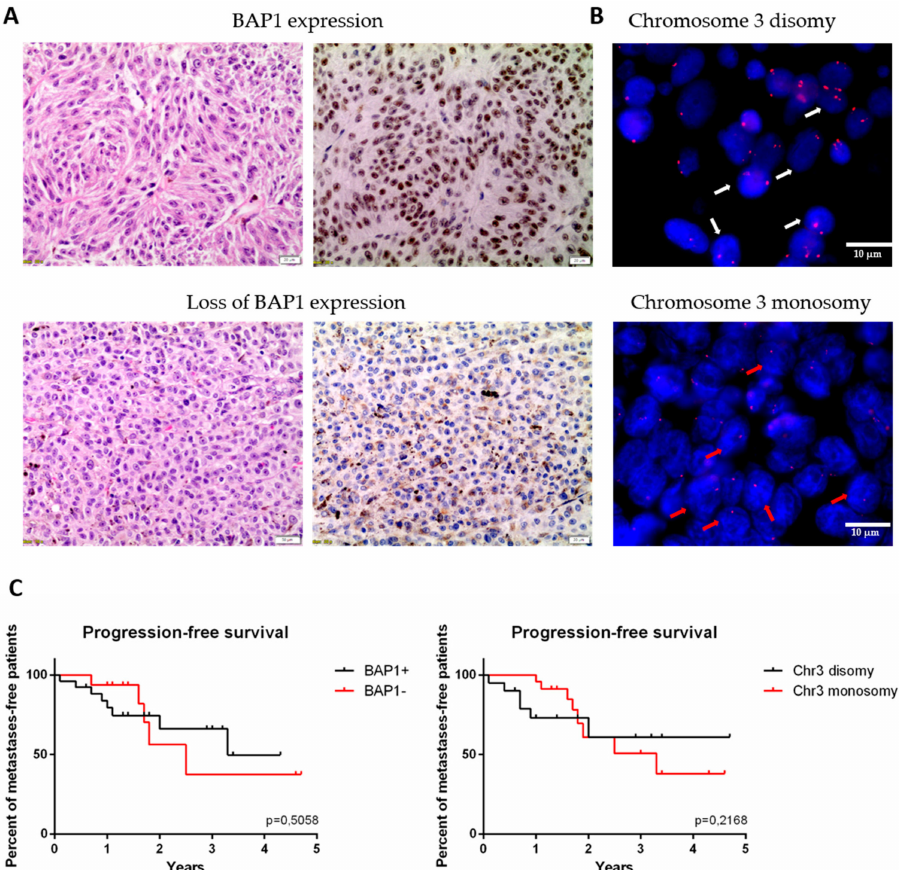
Figure 3. The expression of BAP1 protein and status of chromosome 3 analyzed in formalin fixed and para ffi n embedded (FFPE) primary tumor samples. ( A ) The BAP1 status was analyzed with immunohistochemistry (IHC) staining. Upper panel represents tumor with BAP1 expression, bottom panel represents one with loss of BAP1 (left: hematoxylin and eosin staining; right: IHC for BAP1). Scale bar represents 20 µ m, magnification: 20 × . ( B ) Chromosome 3 status was analyzed with fluorescent in situ hybridization (FISH). White arrows point out the nuclei with chromosome 3 disomy, red arrows with monosomy. Scale bar represents 50 nm, magnification: 100 × . ( C ) Kaplan-Meier survival curves for progression free survival in group with and without BAP1 expression (left) and monosomy 3 (right),